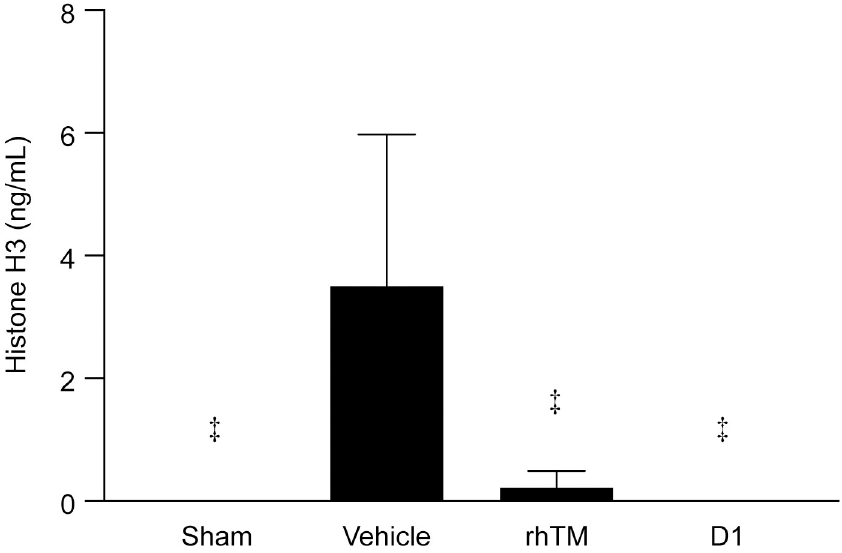
Fig 3. Effect of lectin-like domain 1 (D1) of rhTM on reduction of histone H3 levels in sepsis-induced rats. Administration of rhTM and D1 significantly decreased circulating histone H3 levels. n = 6 per group. ‡ P � 0.001 vs.